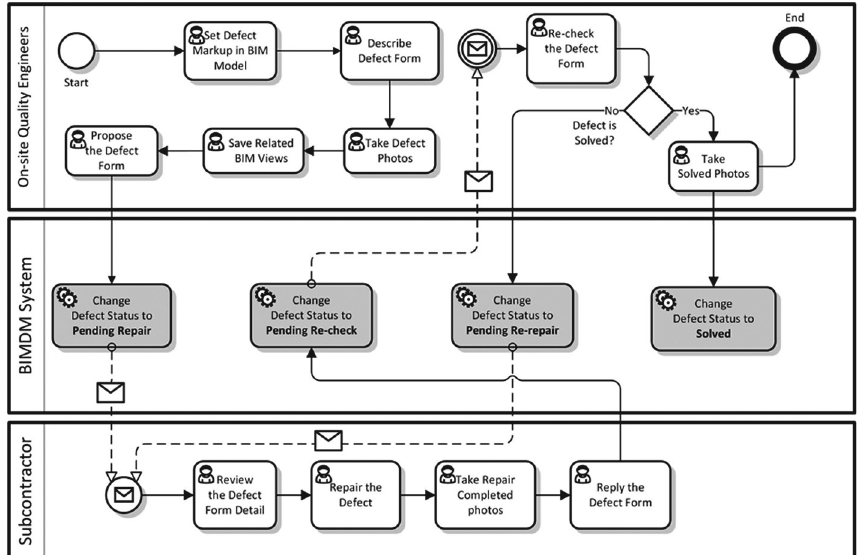
Fig. 5. The system process flowchart used in the BIMFMM